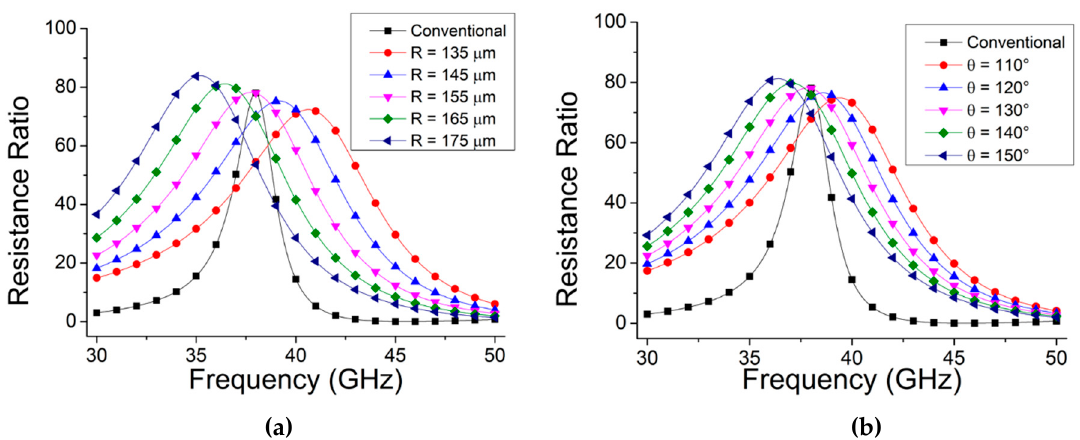
Figure 7. The resistance ratio as functions of frequency for the cases of ( a ) fixed θ of 130 ° with varying R; and ( b ) fixed R of 155 µm with varying. The same ratio for the conventional topology using open stub is also included in the plots.